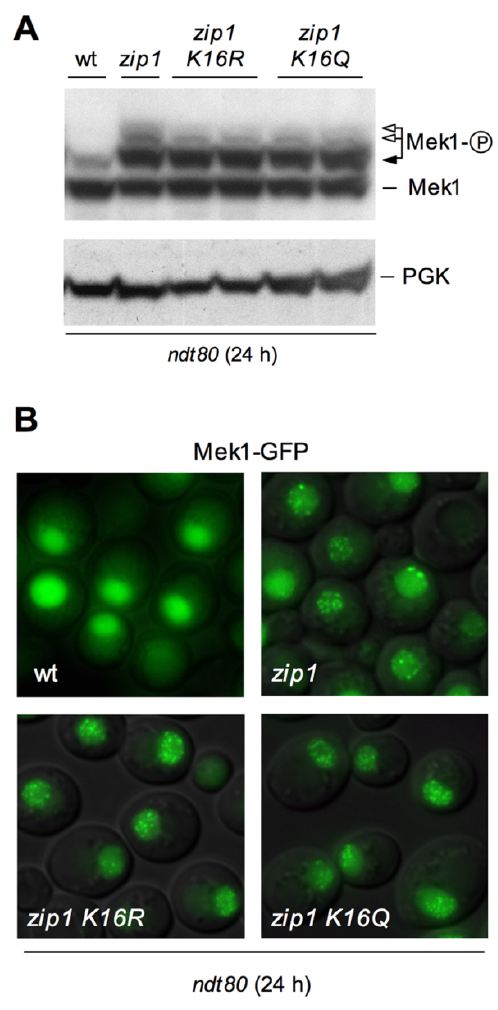
FIGURE 4: Analysis of Mek1 activation and localization in ndt80 - arrested cells. (A) Western blot analysis of different Mek1 phos- phorylation forms in ndt80 -arrested cells after 24 h in meiosis. PGK is shown as a loading control. Strains are DP424 (wild type), DP428 ( zip1 ), DP996 ( zip1 H4-K16R ) and DP1002 ( zip1 H4-K16Q ). Two independent clones of DP966 and DP1002 were analyzed. (B) Representative images of checkpoint-induced Mek1-GFP